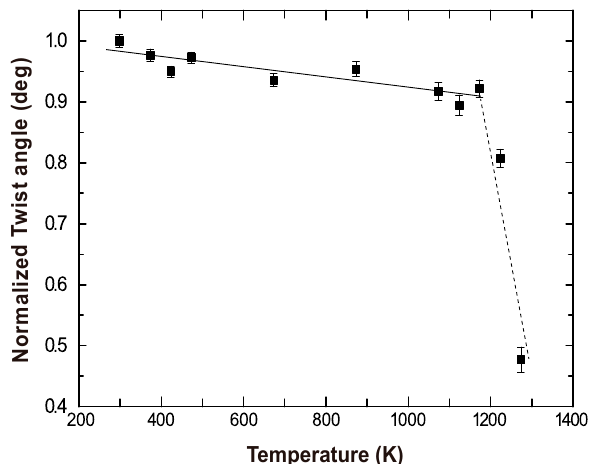
Figure 5. The temperature dependence of the twist angle φ of pyromorphite, from 298 K to 873 K, normalized to the value at 298 K.